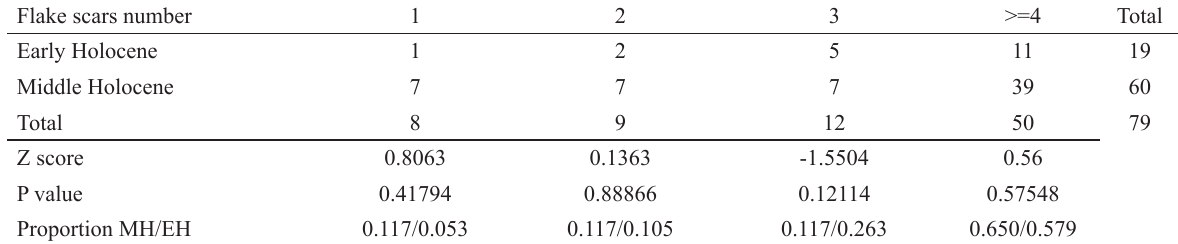
Number of analysed cores, number of scars, Z-test results (z score and p value) and proportion between Middle Holocene (MH) and Early Holocene (EH).